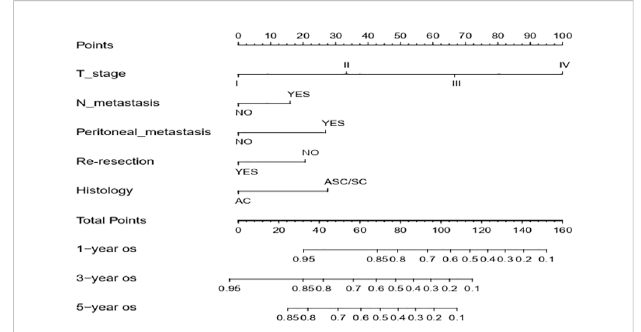
FIGURE 2 Nomogram for estimating the 1-, 3-, 5-year OS of IGBC patients. N metastasis, lymph node metastasis; AC, adenocarcinoma; ASC/SC, adenosquamous or squamous; OS, overall survival.